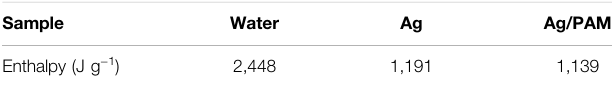
TABLE 4 | Evaporation enthalpy results from DSC measurement of Ag and Ag/PAM.